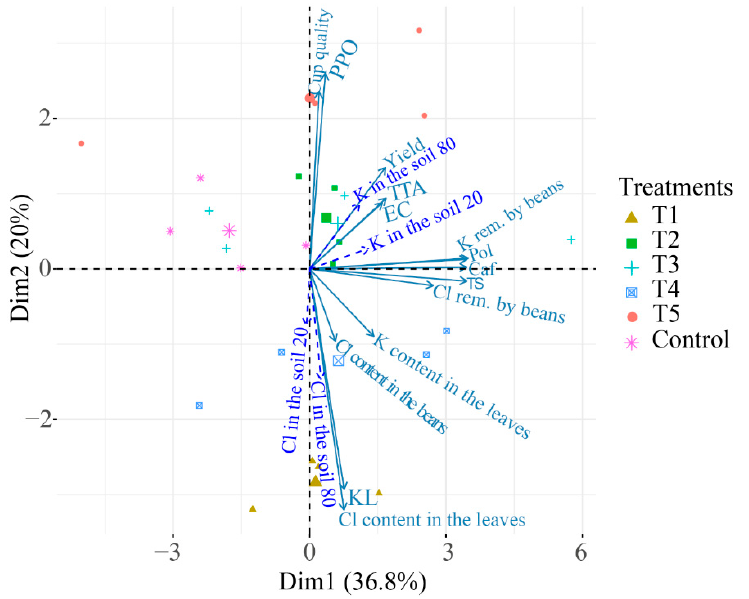
Figure 10. Principal component analysis for the harvest of 2019/2020. PPO = activity of the enzyme polyphenol oxidase; KL = K leaching; TTA = total titratable acidity; EC = electric conductivity; Pol = total phenolic compounds; Caf = content of caffeine; TS = content of total sugars; K in the soil 20 = stock of K in the 0–20 cm layer; K in the soil 80 = stock of K in the 20–80 cm layer; Cl in the soil 20 = stock of Cl in the 0–20 cm layer; Cl in the soil 80 = stock of Cl in the 20–80 cm layer, K rem. by beans: K removal by the beans, Cl rem. by beans: Cl removal by the beans. T1: 100% KCl, T2: 75% KCl + 25% K 2 SO 4 , T3: 50% KCl + 50% K 2 SO 4 , T4: 25% KCl + 75% K 2 SO 4 , T5: 100% K 2 SO 4 .